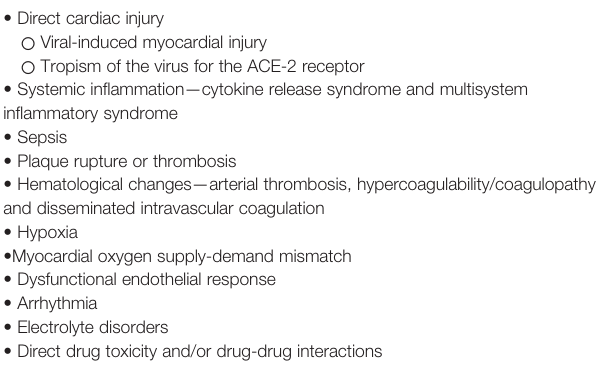
TABLE 2 | Possible causes of cardiac events in COVID-19 infection*. (cid:129) Direct cardiac injury ○ Viral-induced myocardial injury ○ Tropism of the virus for the ACE-2 receptor (cid:129) Systemic in fl ammation — cytokine release syndrome and multisystem in fl ammatory syndrome (cid:129) Sepsis (cid:129) Plaque rupture or thrombosis (cid:129) Hematological changes — arterial thrombosis, hypercoagulability/coagulopathy and disseminated intravascular coagulation (cid:129)